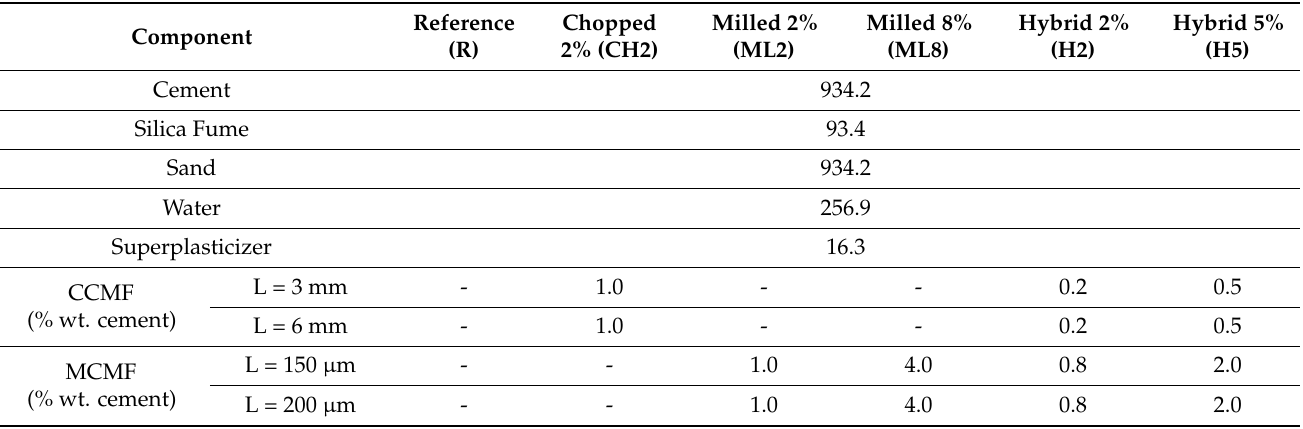
Table 1. Concrete mix design (kg/m 3 ).